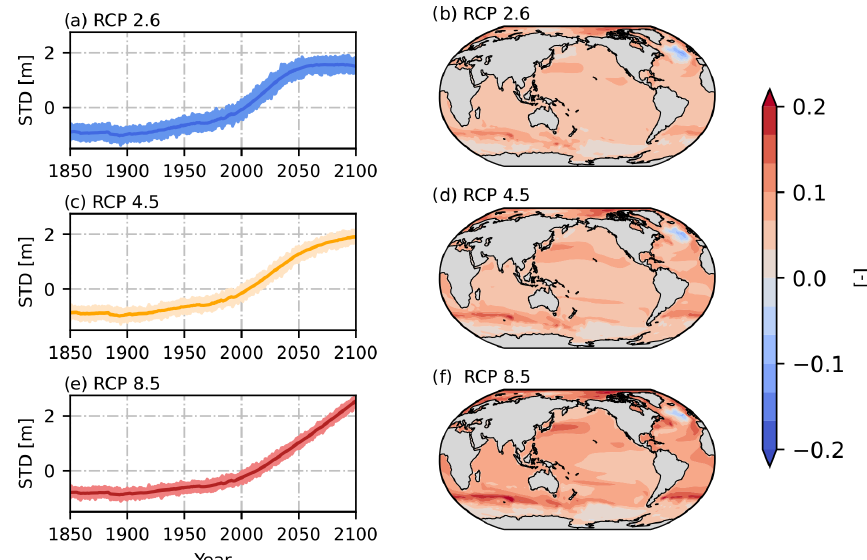
Figure 3. Time evolution of DSL standard deviation ( a , c , and e ) and associated S/N M EOF pattern number 1 for RCP2.6, 4.5, and 8.5 ( b , d , and f , respectively). Light colored lines in (a) , (c) , and (d) represent standard deviation anomalies from ensemble members, whereas dark colored lines depict the ensemble-mean evolution of the pattern. In the historical + RCP scenarios DSL is calculated relative to the mean of 1993–2012.